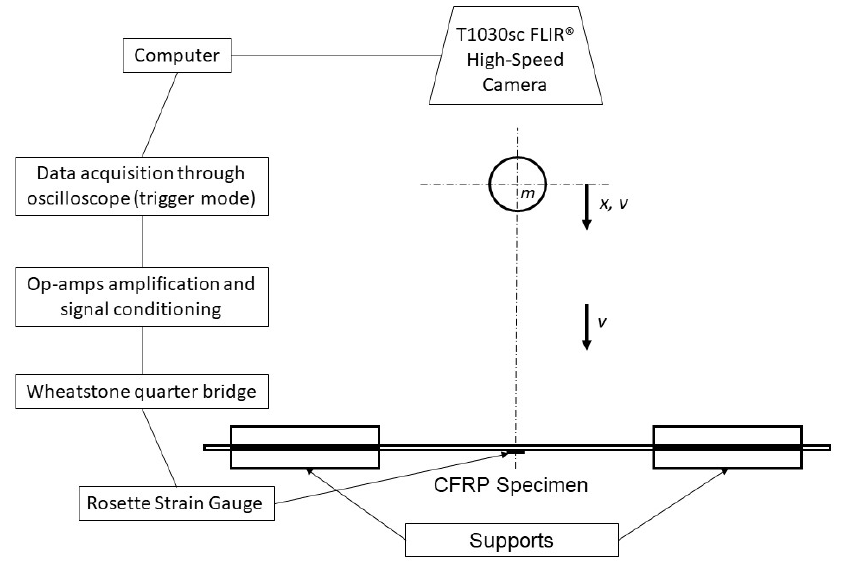
Figure 6. Diagrammatic representation of the experiment.